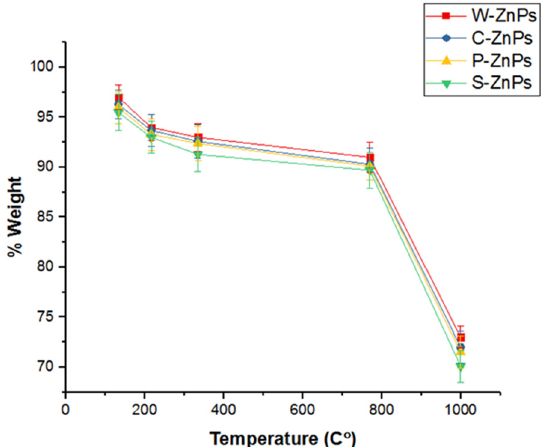
Figure 4. Thermal stability of ZnO NPs at different temperatures. The experiment was carried out in triplicate. The values given in figure are mean ± standard deviation of the original data.